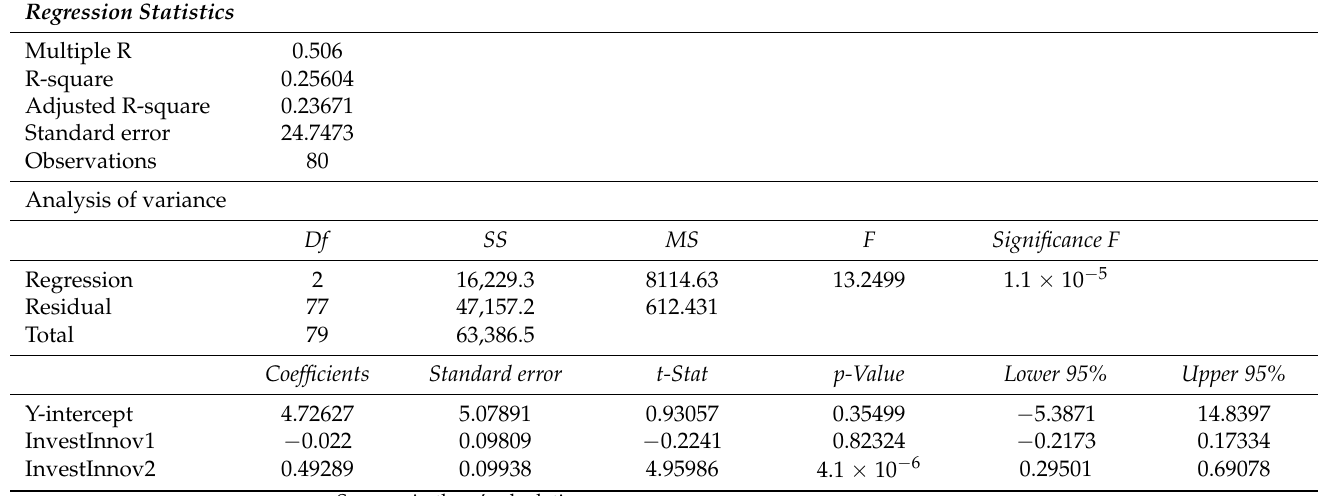
Table A7. Regression statistics of the dependence of Frisk 2 on investments in innovation (InvestIn- nov).